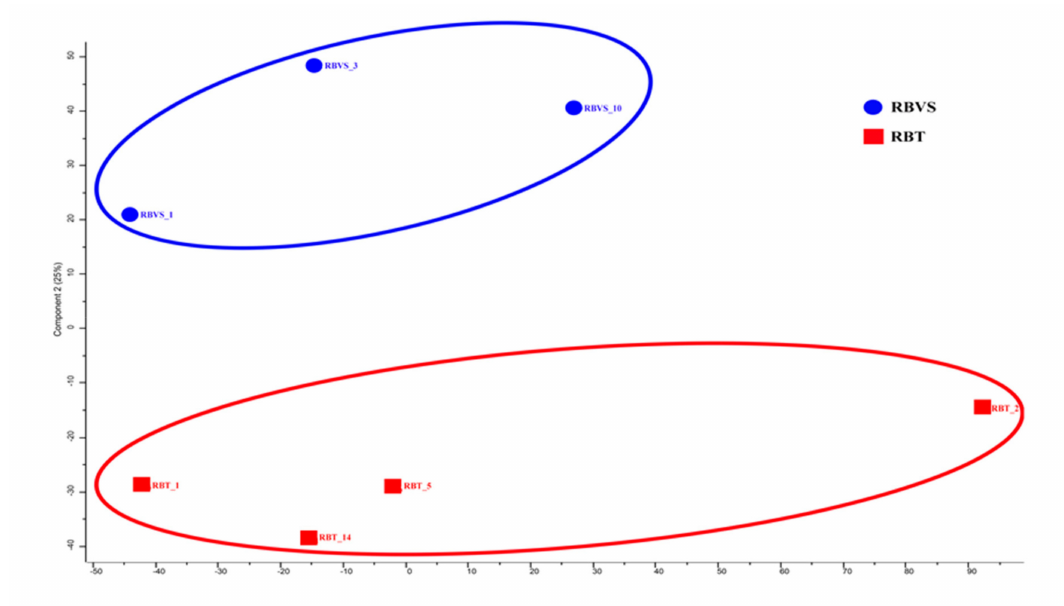
Figure 5. Level of similarity of individual samples. Multidimensional scaling (MDS) and k-means analysis of exosomes of RBT and RBVS proteome profile. Two-dimensional scatter plot of MDS and k-means analysis of RBT (red square) and RBVS (blue square) exosomes shows a clear discrimination between the two types of samples. The average value of the three replicates analyzed is